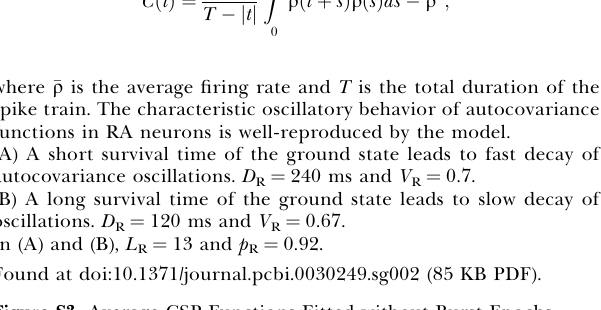
Figure S2. Autocovariance Functions of RA Spike Trains during Sleep